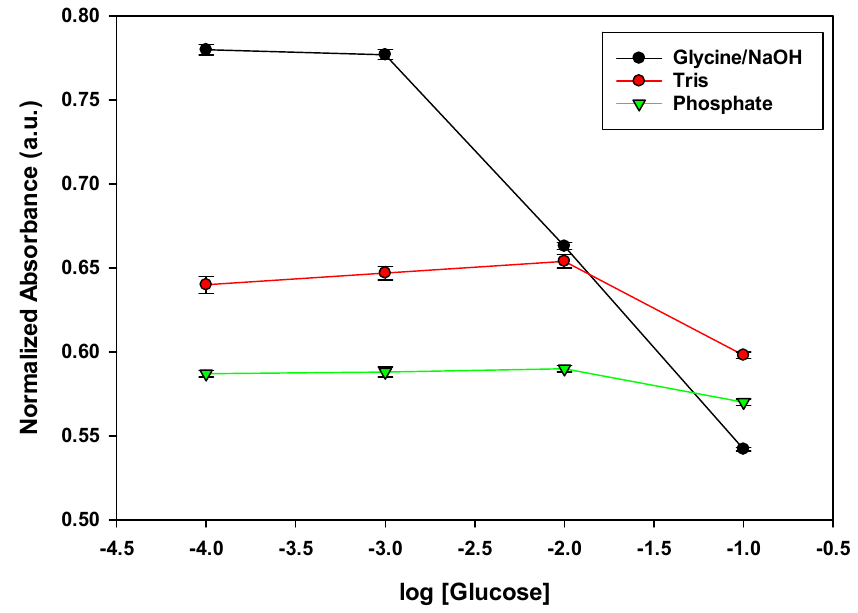
Figure 4. Calibration curves with error bars for optode 3 in different pH and buffers. The standard deviation was obtained through 5 measurements.